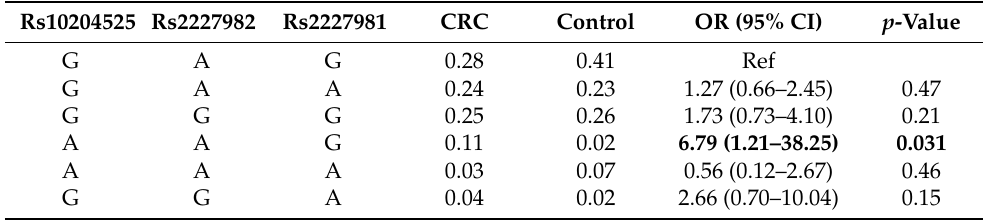
Figure 1. Linkage disequilibrium (LD) plots of three SNPs in the PD-1 gene region. The plot for subjects with CRC ( left ) and control ( right ) were generated by Haploview. The numbers in the squares show the D ’ values between the SNPs, expressed as percentages within the respective squares. Table 6. Association of PD-1 haplotypes with CRC in Saudi